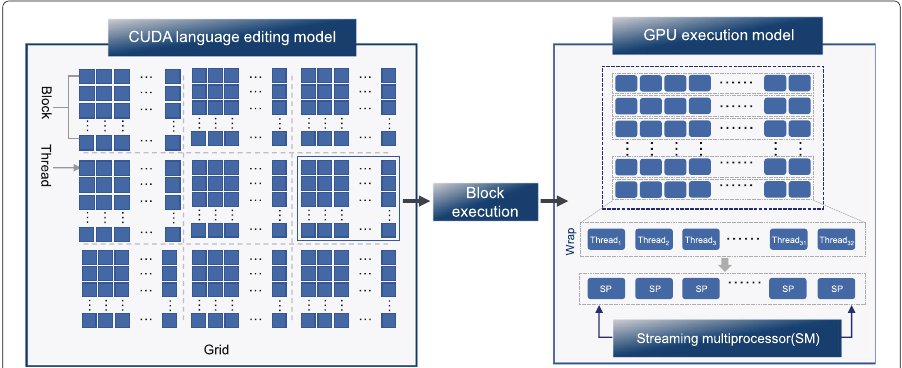
Fig. 32 The schematic diagram of calculation process of Compute Unified Device Architecture (CUDA)